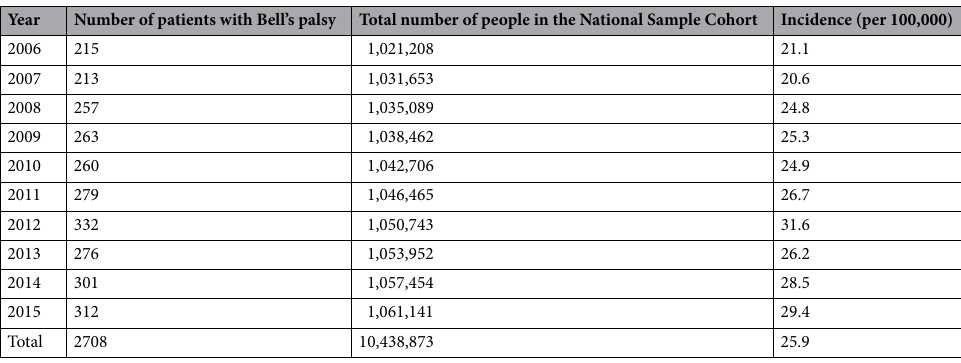
Table 1. The number of patients and incidence of Bell’s palsy from 2006 to 2015 based on the National Sample Cohort data of